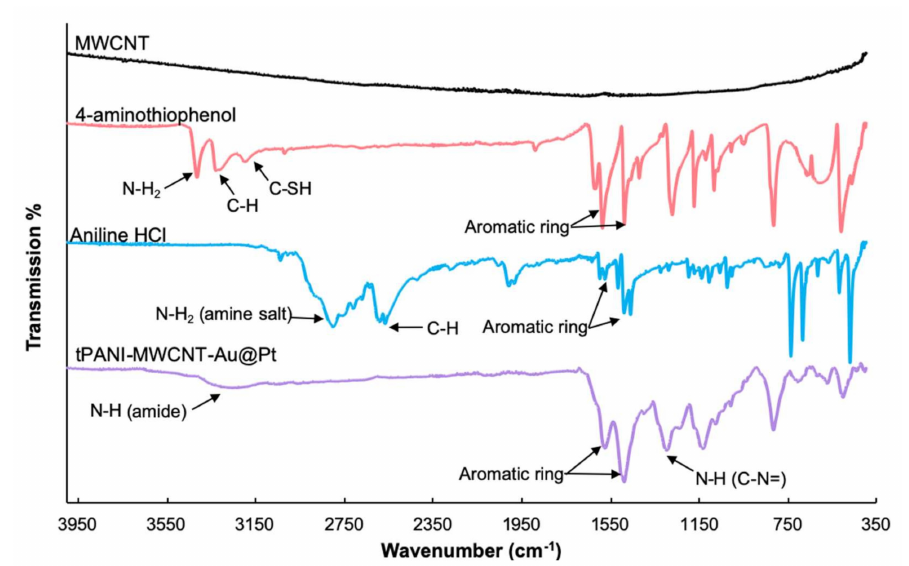
Figure 1. FT-IR spectra of MWCNTs (black), 4-aminothiophenol (red), aniline HCl (blue), and the final nanocomposite